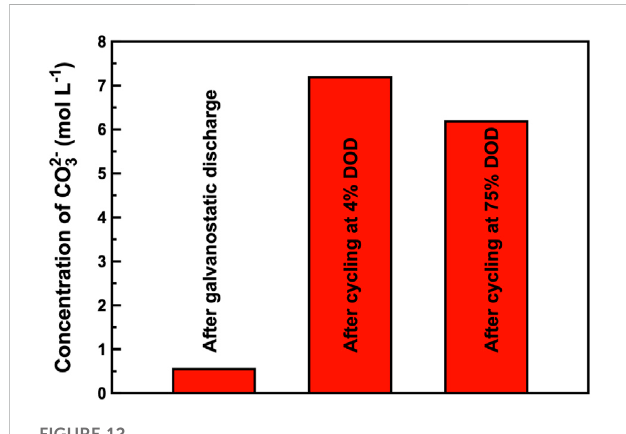
FIGURE 12 Concentration of CO 3 2 – in electrolyte after galvanostatic discharge and cycling,